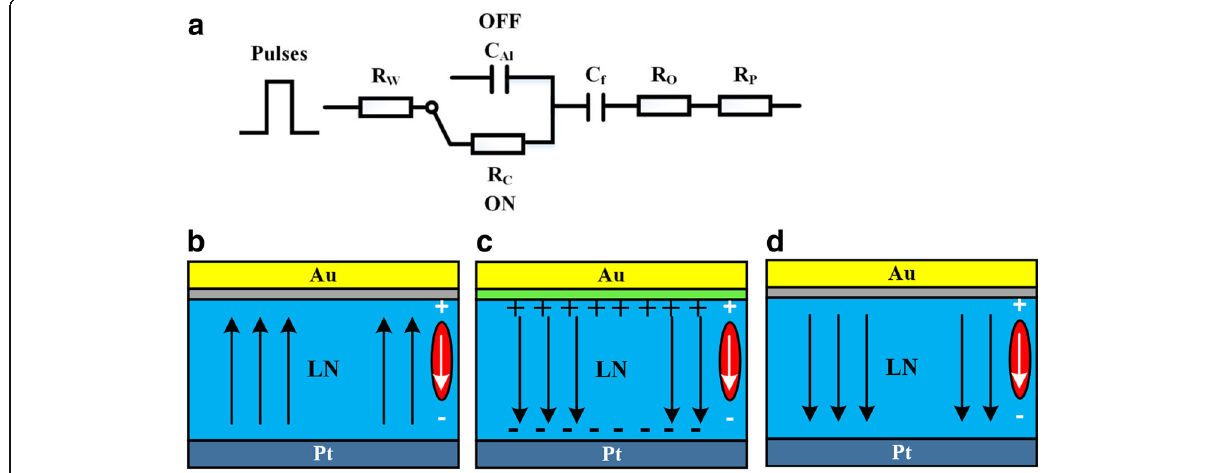
Fig. 5 Schematic diagrams of the Al 2 O 3 /LN bilayer structure switched in type I or type II. a The sketch of the equivalent on-off circuit of the in- series resistors and capacitors for the Al 2 O 3 tunnel switch. b Initial preferred polarization orientation and built-in electric field; c The Al 2 O 3 tunnel switch turning on and domain switching; d The Al 2 O 3 tunnel switch switching off and polarization